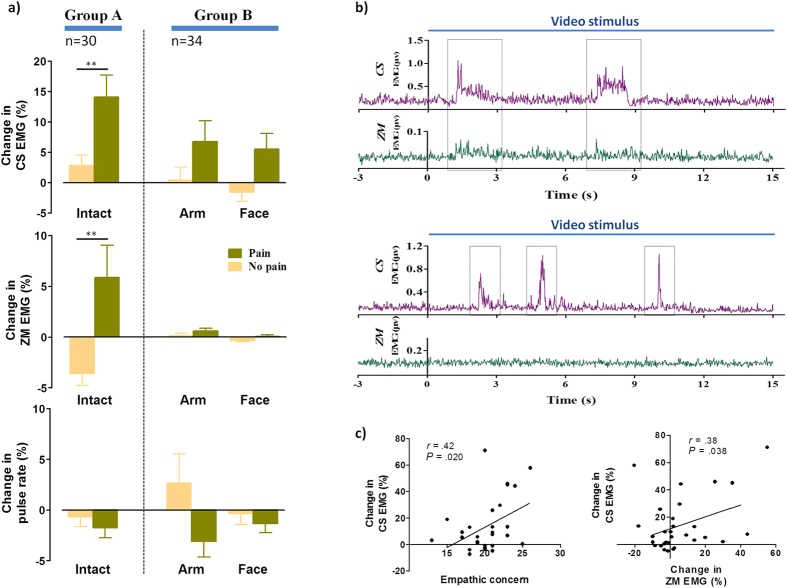
Physiological responses to video stimuli and relationship between facial electromyographic (EMG) data and empathy scores.(a) Within-subject and between-subject comparisons of physiological indices. Corrugator supercilii (CS) and zygomaticus major (ZM) EMG responses and pulse rate were converted to percent changes from baseline. Pain videos enhanced both facial EMG responses as compared with no-pain videos. **P < .01. Error bars represent standard errors of the mean. (b) Examples of facial EMG responses from two observers. Different spatial patterns and temporal dynamics can be seen in response to the same pain video clip, with activation of both facial muscles in one observer (upper) and CS activation only in the other observer (lower). Dotted outlines indicate the enhancement of EMG signals. (c) Positive correlations of CS EMG activity with empathic concern subscale score (left), and ZM EMG activity (right). Correlations were found only in trials employing the whole-body pain video, not in those using the arm-only and face-only pain videos.